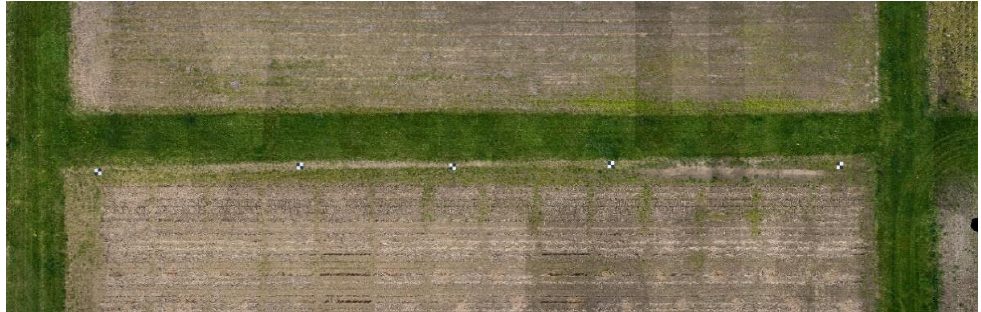
Figure 15. Sony A7R calibration field.